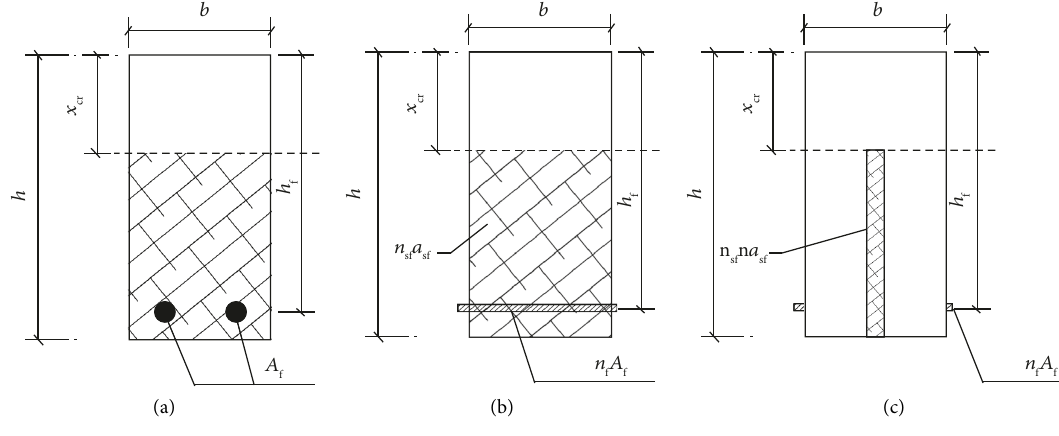
Figure 9: Equivalent simplified